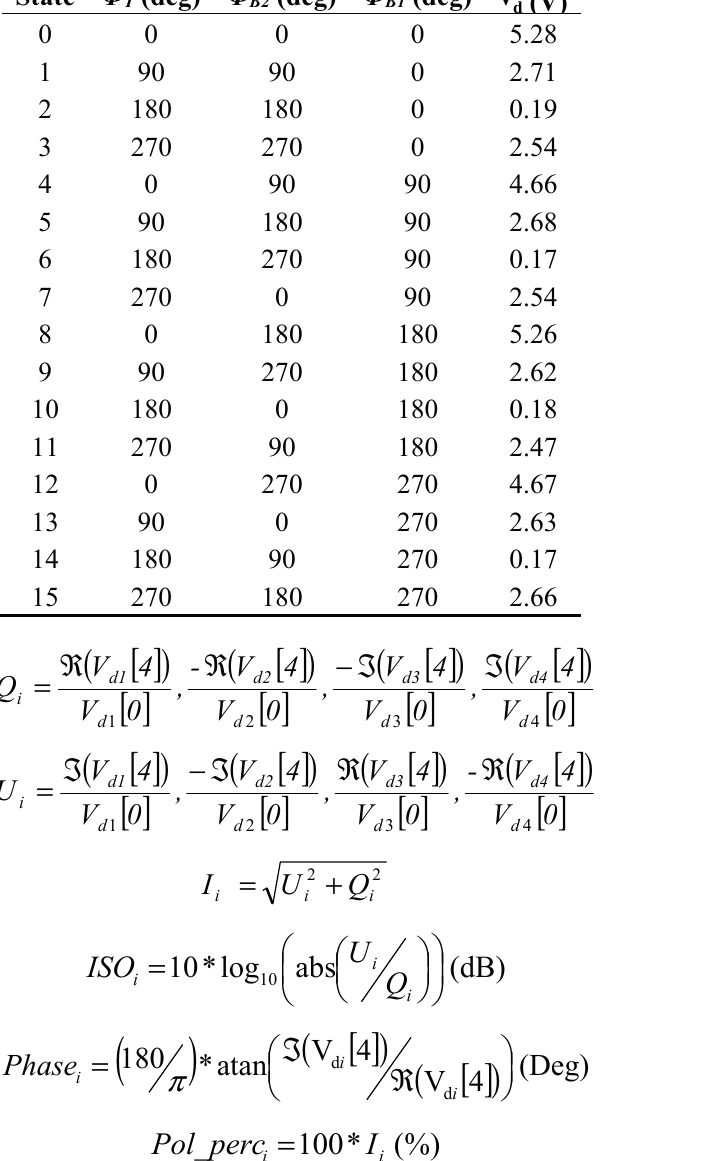
Table 2. Detected voltage values for each of the phase-states forming a saw-tooth